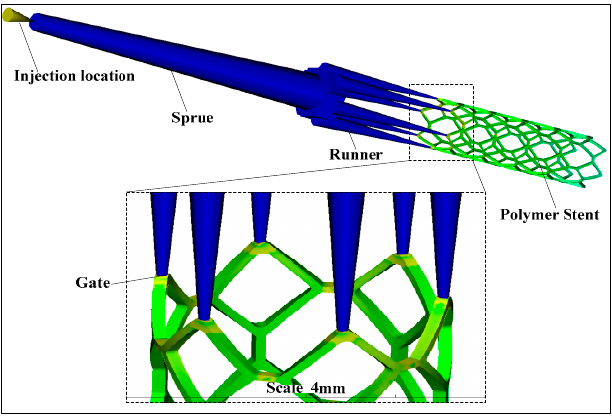
Figure 4. The injection molding process of stent based on the MOLDFLOW.